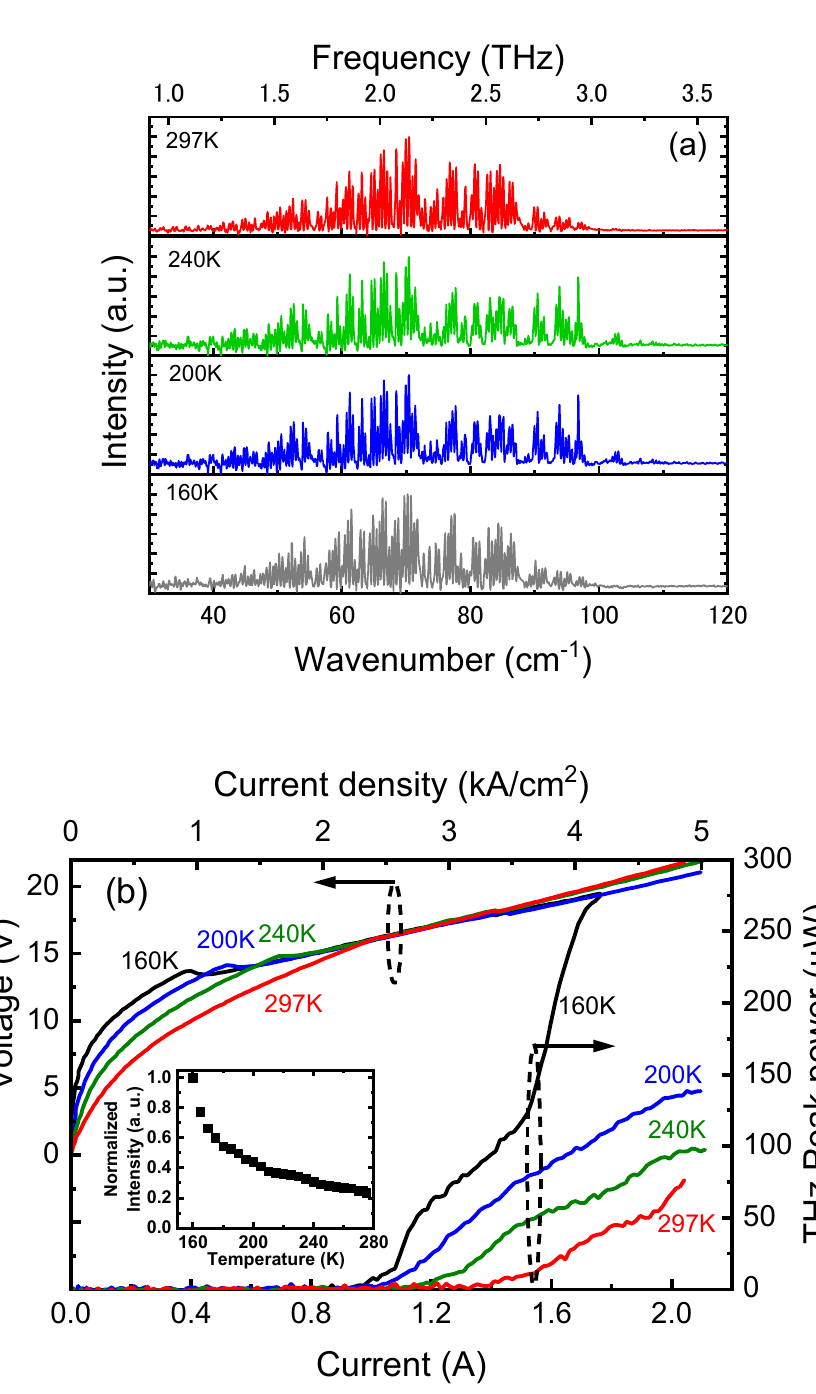
Figure 1. ( a ) Spectra of the THz NL-QCL (terahertz nonlinear quantum cascade laser): at 297 K, 240 K, 200 K and 160 K. ( b ) Current-voltage-THz-light-output characteristic of the THz NL-QCL at different temperatures, measured in pulsed mode. Inset shows normalized output intensity of THz NL-QCL as a function of temperature.